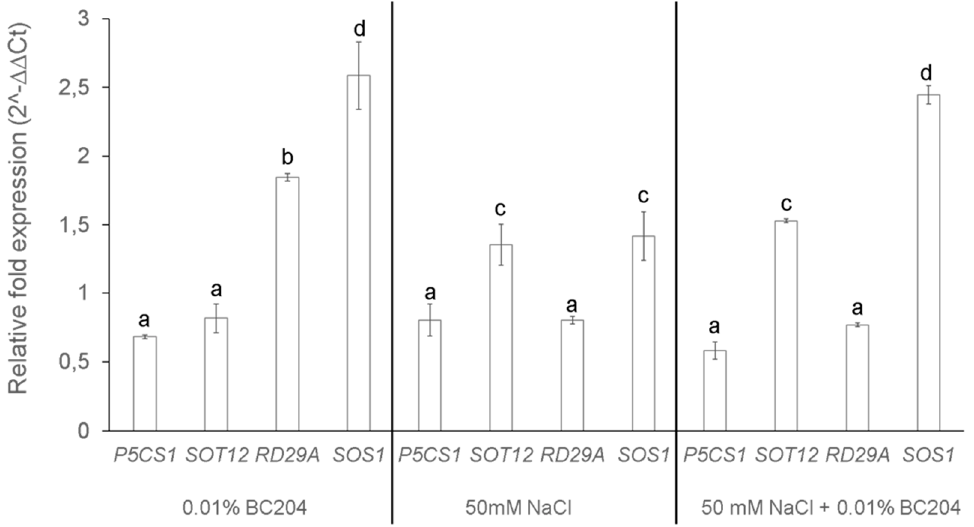
Figure 7. Relative fold expression of NaCl-responsive genes in A. thaliana shoot tissue under BC204 and NaCl-stress and a combination of both. Histograms represent relative transcript expression levels of Reverse Transcriptase Quantitative PCR (RT-qPCR) in the shoot tissue of plants treated with BC204 (0.01%), NaCl-stressed (50 mM) and BC204 (0.01%) combined with NaCl-stress (50 mM). Ct values were averaged and normalized to Efl α (At1g18070) according to the 2 − ∆∆ Ct method [80]. The expression values for all genes for the untreated control plants were set as 1. Bars represent the mean of three replicates ( n = 3) ± standard error. Different letters indicate values that were determined by one-way ANOVA with Fisher’s LSD post-hoc test to be significantly different ( p < 0.05) from the control.